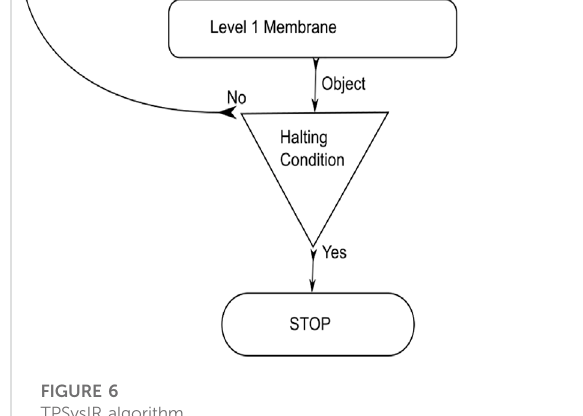
FIGURE 6 TPSysIR